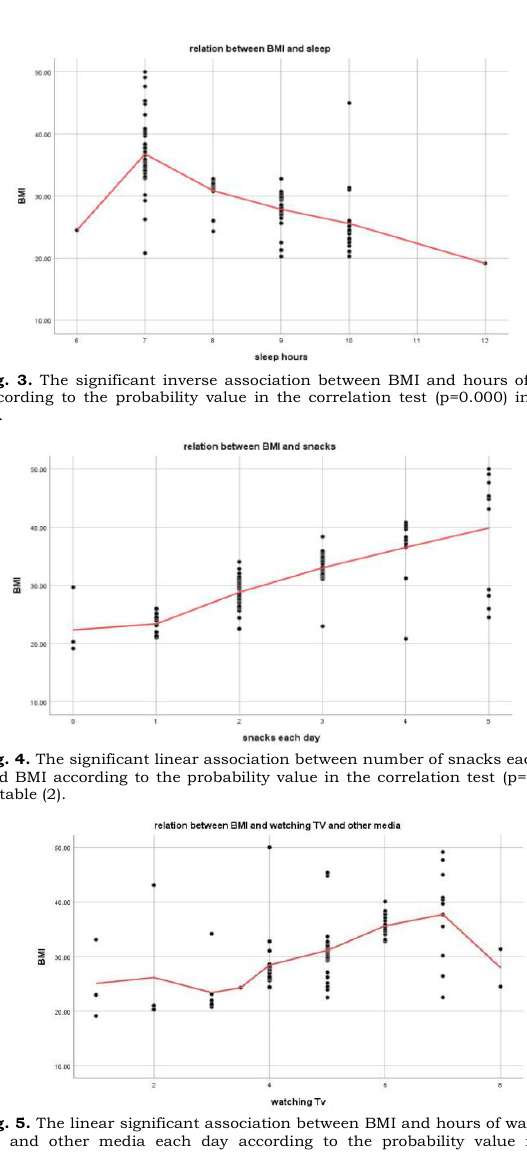
Fig. 2. The significant inverse association between BMI and physical activity according to the probability value in the correlation test (p=0.000) in table (2).